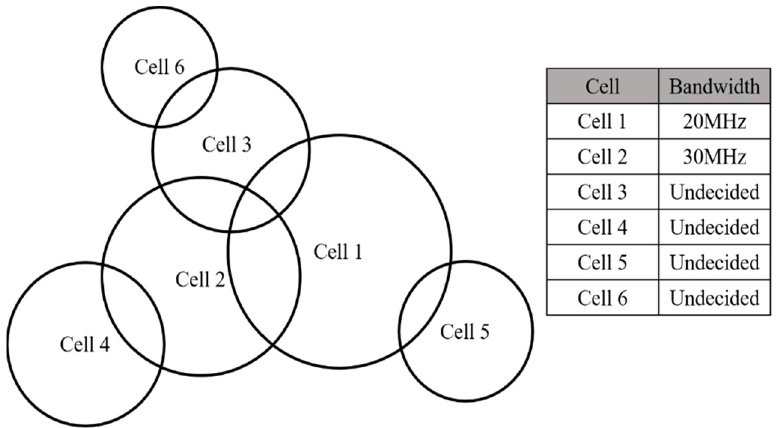
Figure 4. Example of Algorithm 1